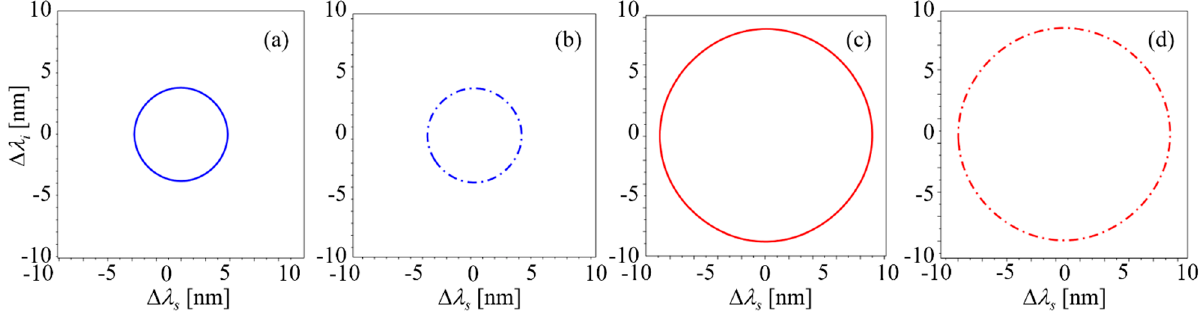
Figure 9. Contour lines for joint spectral intensity (JSI) = 0.5 for the cases shown in Figure 8: ( a ) LN, ( b ) 5 mol%-MgO:LN ( c ) PPLN, and ( d ) 5 mol%-MgO:PPLN. The diameters of the circles are 7.6 nm, 7.8 nm, 17.3 nm, and 17.8 nm, in the order of Figure 9a–d. Each result was calculated for a crystal length of 10 mm.